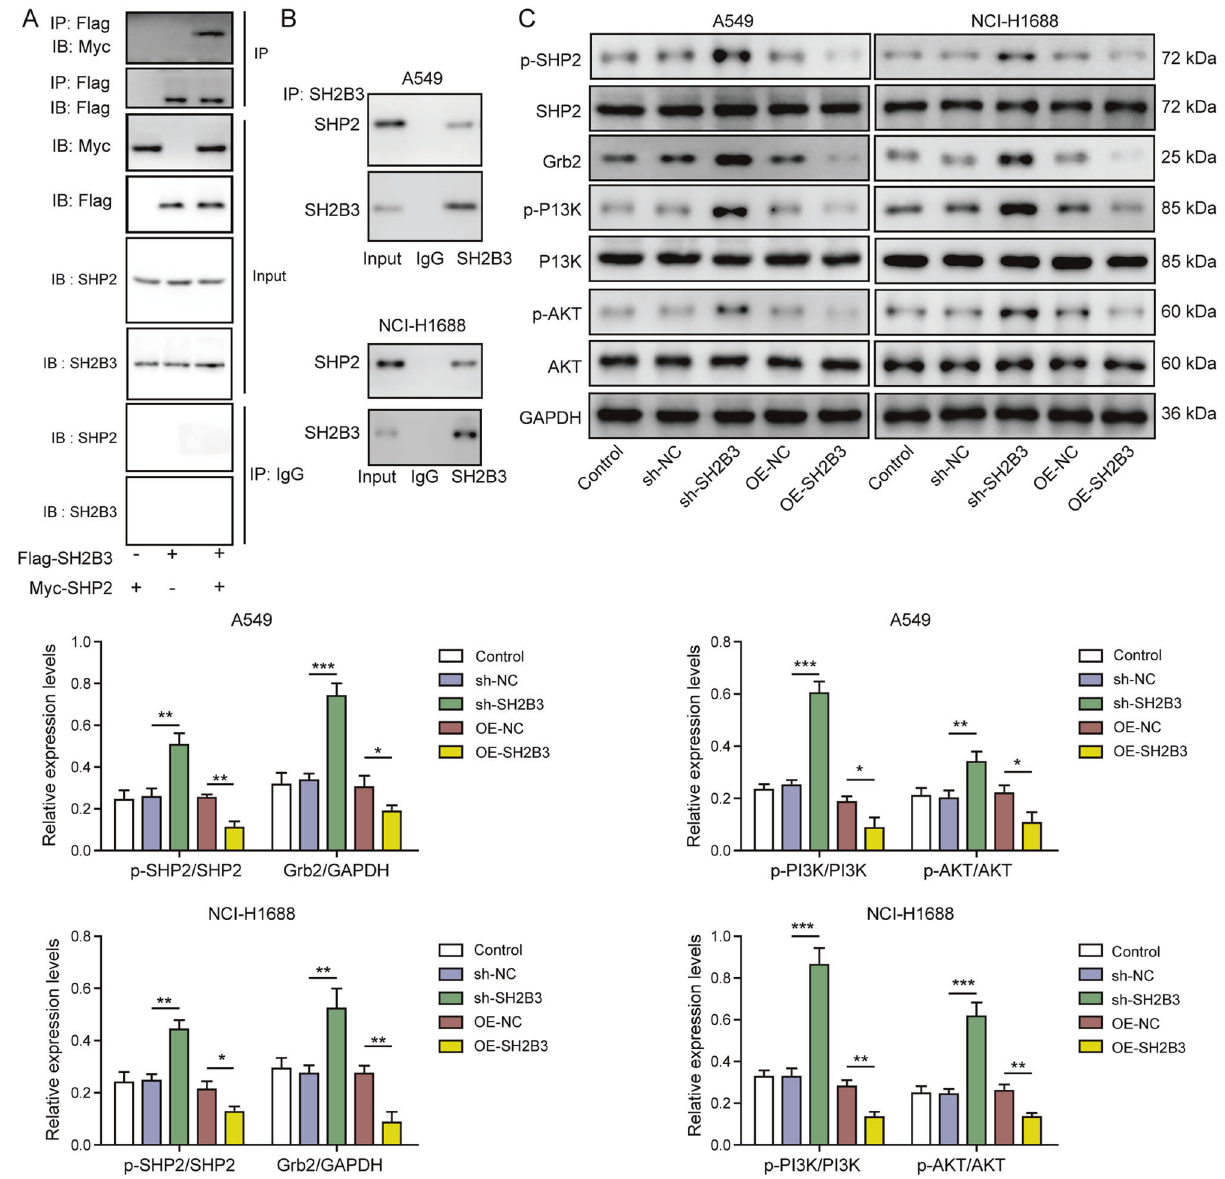
Fig. 5 SH2B3 bound to SHP2 to inhibit SHP2/Grb2/PI3K/AKT signaling. A Immunoblotting for Flag, Myc, SHP2, and SH2B3 following immunoprecipitation with Flag antibody in transfected cells. B Immunoblotting for SHP2 following SH2B3 immunoprecipitation in cancer cells. C Western blotting to determine protein levels of p-SHP2, SHP2, Grb2, p-PI3K, PI3K, p-AKT, and AKT in transfected cancer cells. *** P < 0.001, ** P < 0.01, and * P <